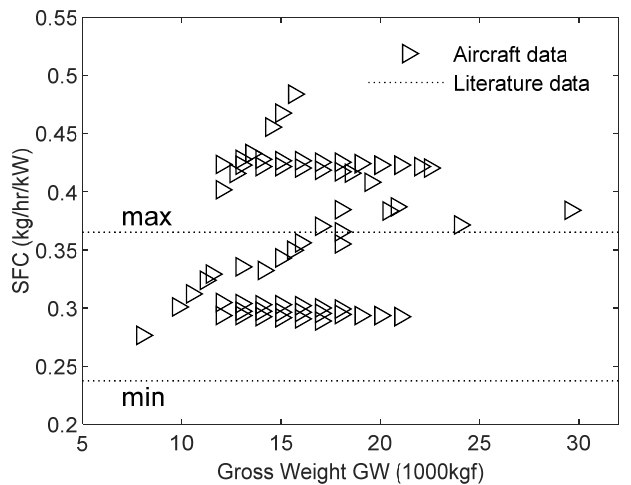
Figure 8. Power Specific Fuel Consumption in cruise at maximum constant altitude.